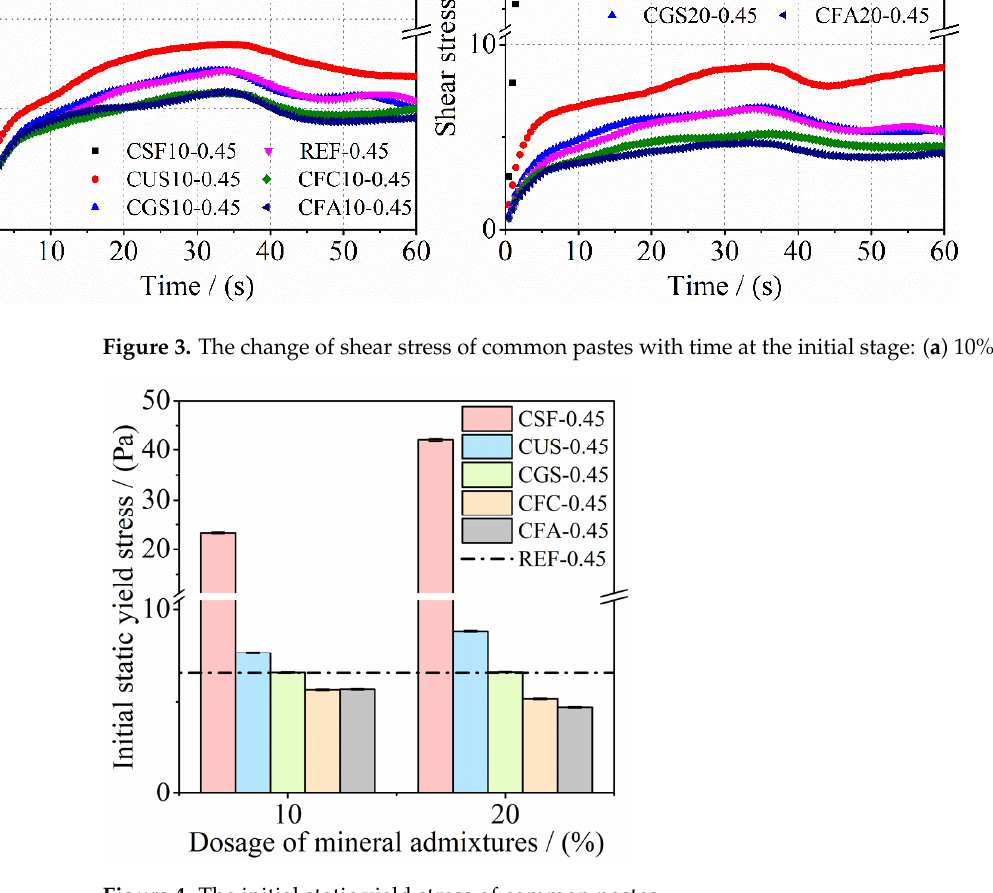
Figure 4. The initial static yield stress of common pastes.